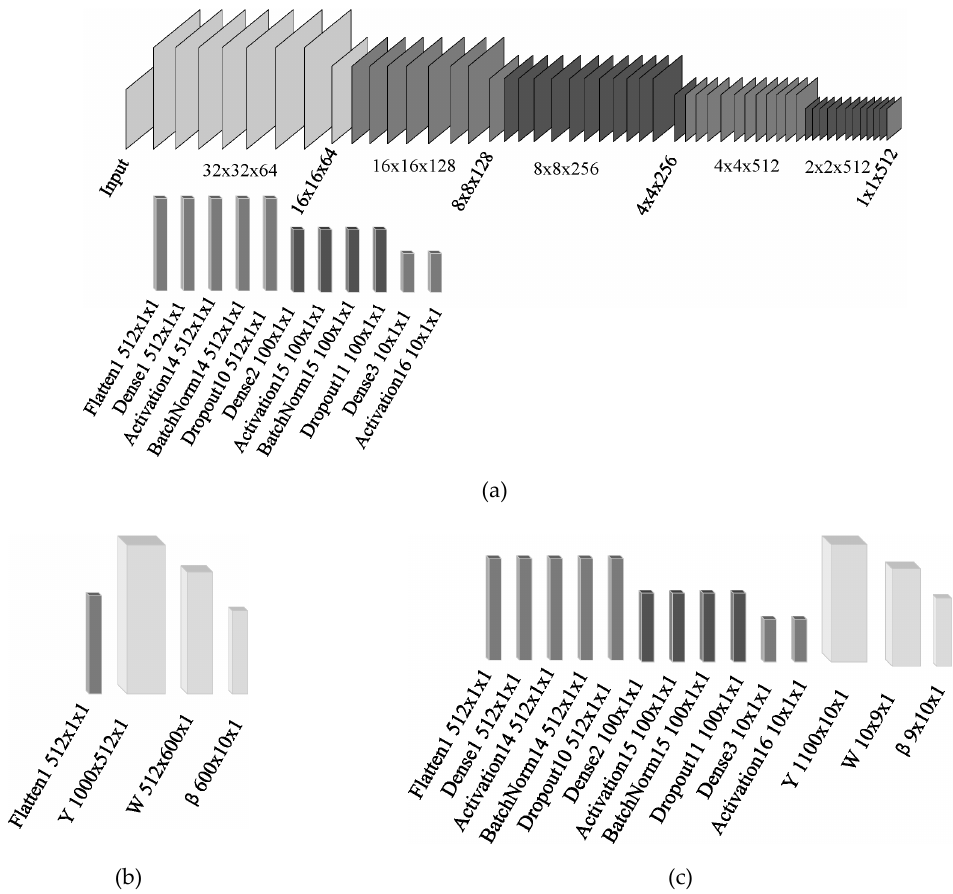
Figure 5. The network structure of VGG16 and fnnmOS-ELM. ( a ) Modified VGG16 network structure used as the pre-training model, divided into two parts: feature ex- traction and classifier. The fnnmOS-ELM network structure on the CIFAR-10 dataset with ( b ) 𝑖 = 55 and ( c ) 𝑖 = 65 .